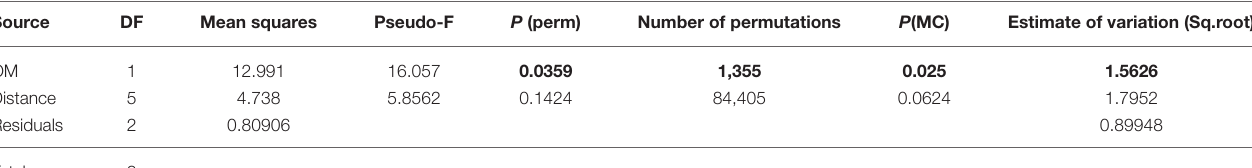
FIGURE 1 | PCA representation of stations at the fallow site according to element and chemotherapeutant concentrations, after log + 1 transformation and normalization of data. Circle sizes are relative to % OM and colors indicate distance to cage.